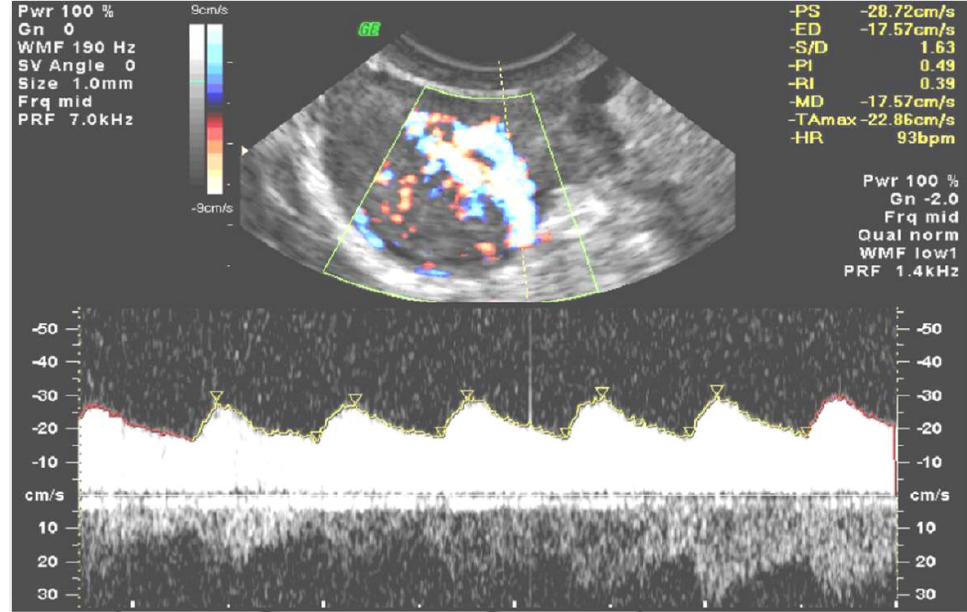
Figure 9. Spectral Doppler. Assessment of the blood flow in a single tumor vessel. The results of calculated 2D flow indices (S/D, PI, and RI) can be seen in the upper right corner.